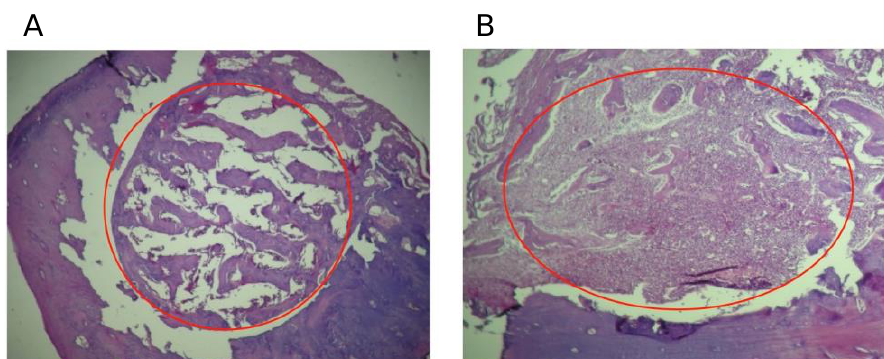
Figure 5. Histological analyses of the defect implanted in the animals. ( A ) The defect was implanted with colloidal NHAP-Q chitosan dispersion (protocol A, Group 1, 4 weeks). ( B ) The defect was implanted with colloidal AgNP-Q chitosan dispersion (protocol A, Group 2, 4 weeks). No signs of significant inflammation were observed in both images. Magnification, 10×. Hematoxylin and eosin were used for staining. The red circle corresponds to the area of the defect.